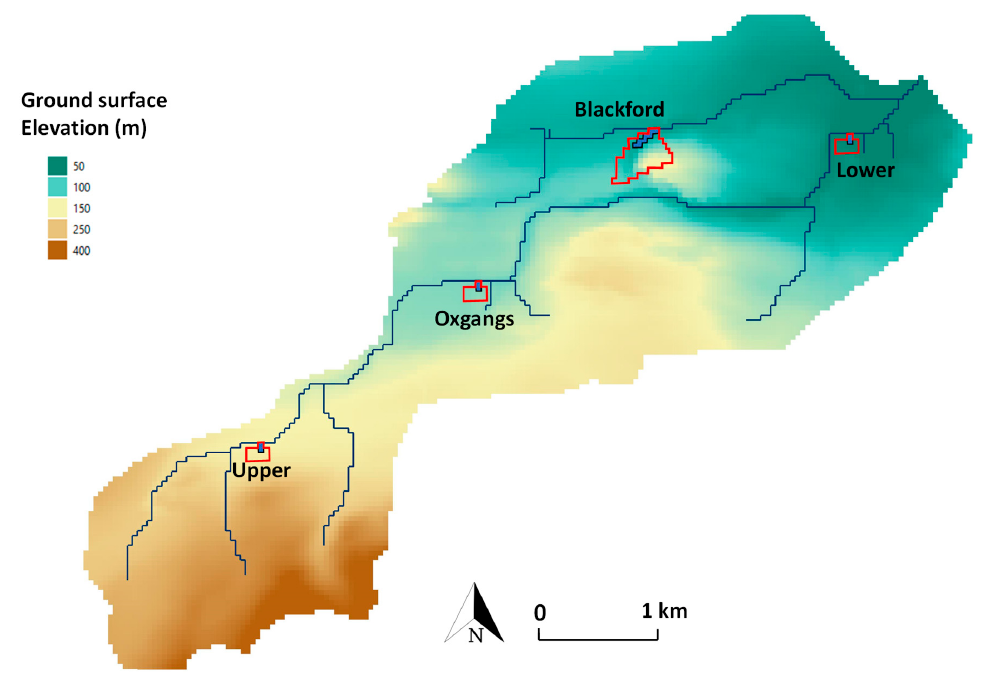
Figure 2. The Braid Burn catchment elevations. The location of the four ponds considered in this work and their modeled catchment boundaries are also shown. The 50 m model grid resolution and the modeled river channels can be